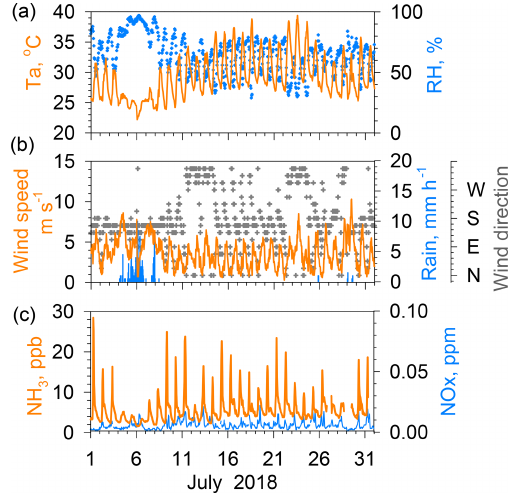
Figure 2. (a) Temperature and relative humidity. (b) Wind speed, rain rate, and wind direction. (c) NH 3 and NO 2 concentrations in Nagoya during July 2018.